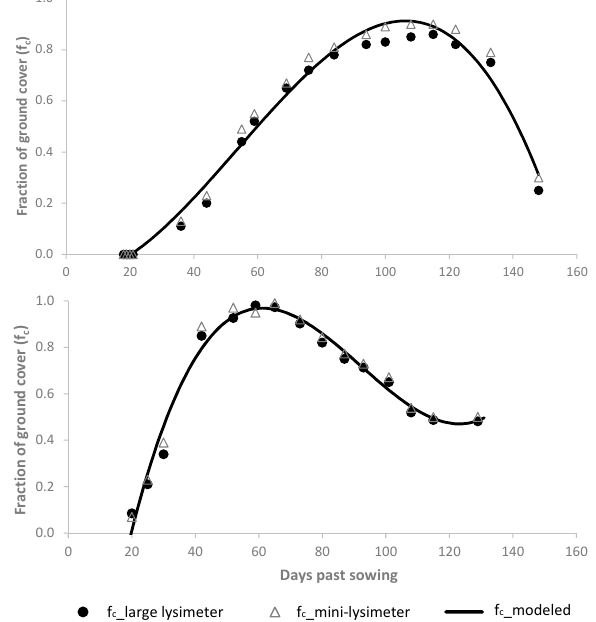
Figure 3. Evolution of the fraction of ground cover throughout the barley (top) and potato (bottom) growing seasons. Dots and triangles are ground measurements within the large and mini-lysimeter, respectively. In both seasons, a third-degree polynomial function was fitted to observations as follows: y = 1.735 × 10 − 6 x 3 + 2.802 × 10 − 4 x 2 − 7.943 × 10 − 4 x − 0.085; R 2 = 0.984 for barley in 2017 and y = 4.203 × 10 − 6 x 3 − 1.162 × 10 − 3 x 2 + 0.095x − 1.457; R 2 = 0.973 for potato in